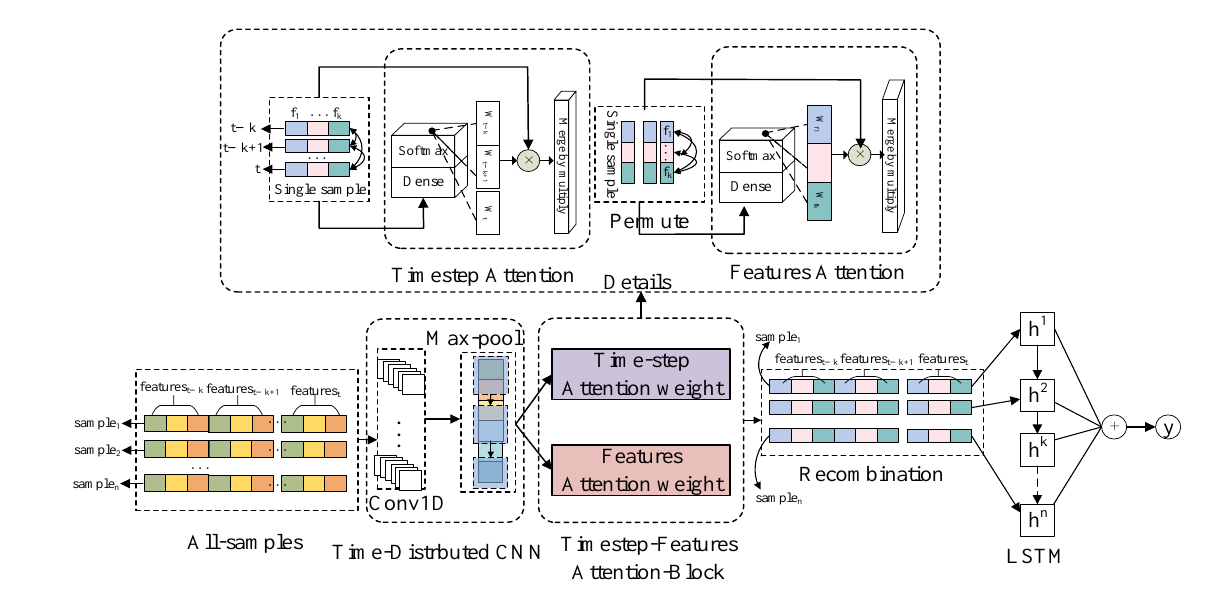
Figure 4. The basic model of TC-DLDPM.